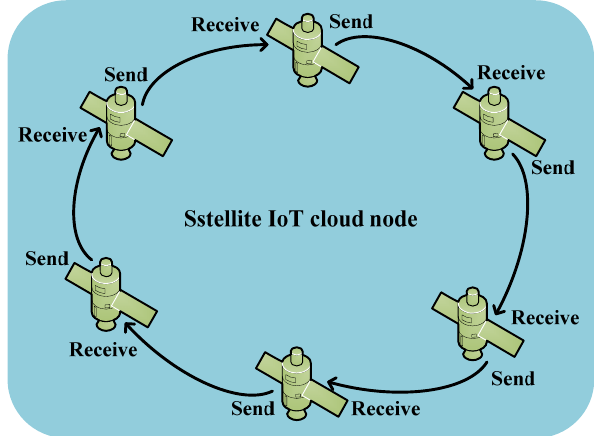
Figure 3. Training-inference-isolated satellite IoT edge intelligent computing architecture.